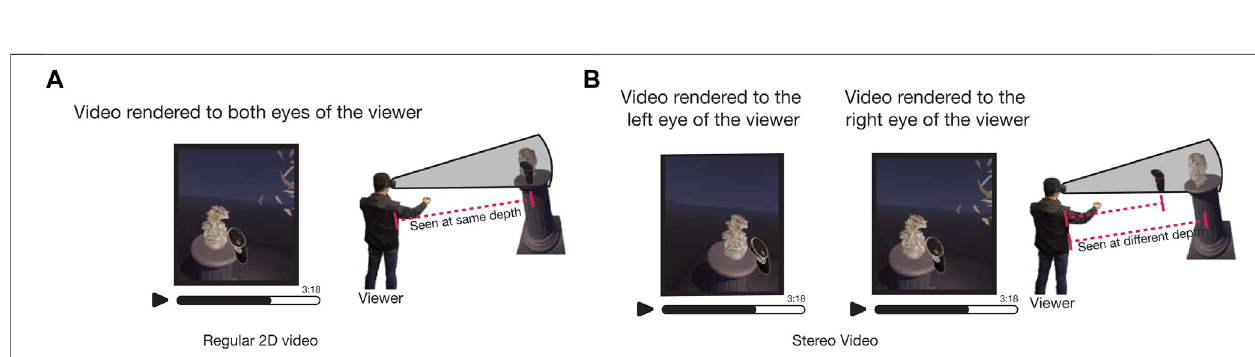
FIGURE 10 | (A) 2D Video suppresses depth information (B) Stereo video preserves the relative depth scene.